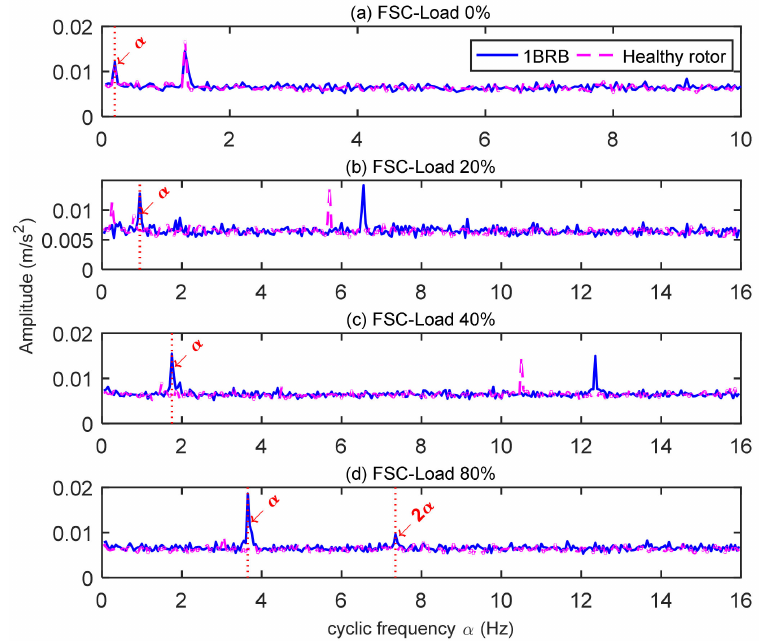
Figure 12. Vibration spectrum of the healthy induction motor and faulty motor with one BRB analysed by FSC under ( a ) 0% load, ( b ) 20% load, ( c ) 40% load, and ( d ) 80%